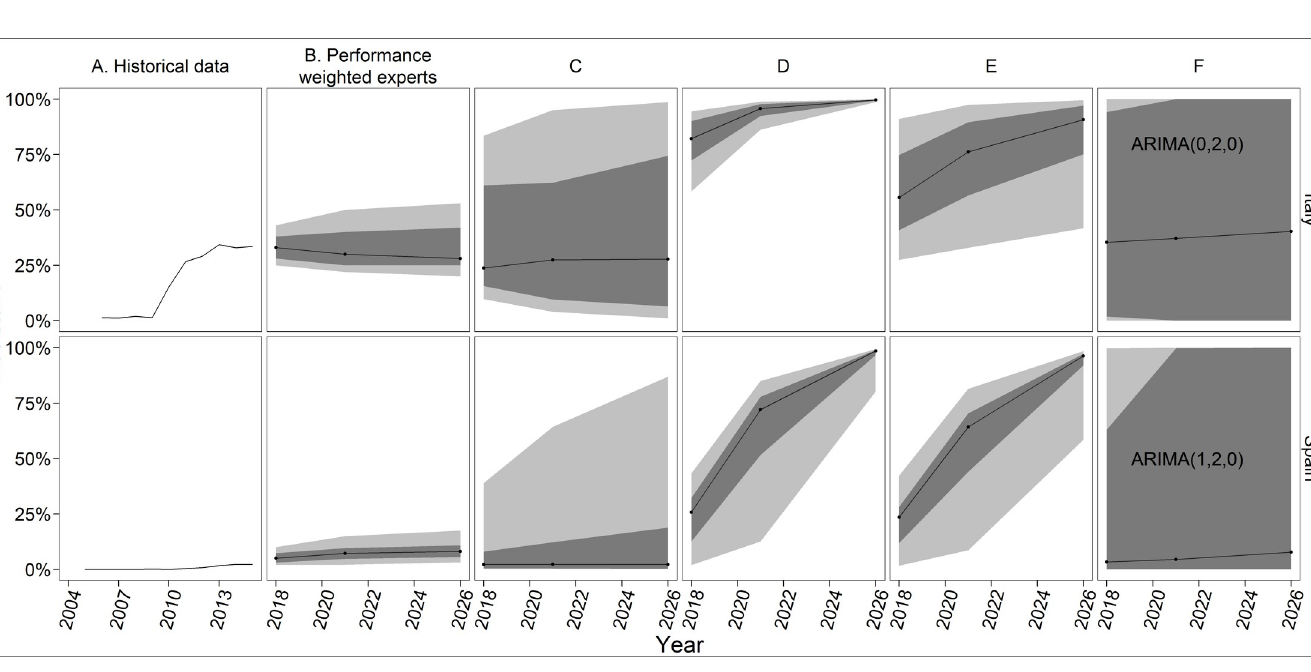
Fig 3. PW and forecasting results for K . pneumoniae resistance to carbapenems in Italy and Spain. All forecasts begin with 2018, 3 years after the most recent historical data. Black lines indicate the median, dark grey indicates the 50% prediction interval, and light grey indicates the 90% predication interval. The experts only assessed 2018, 2021, and